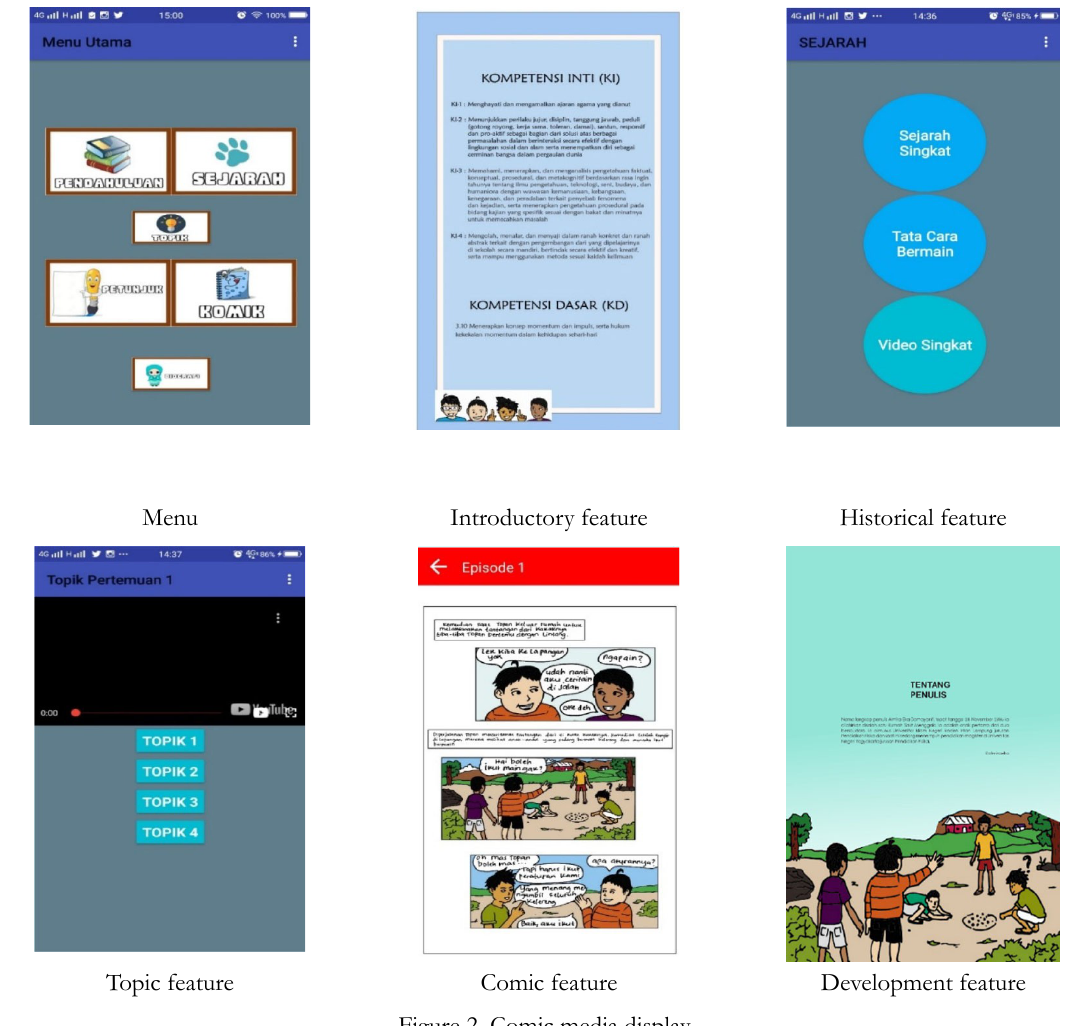
Figure 2. Comic media